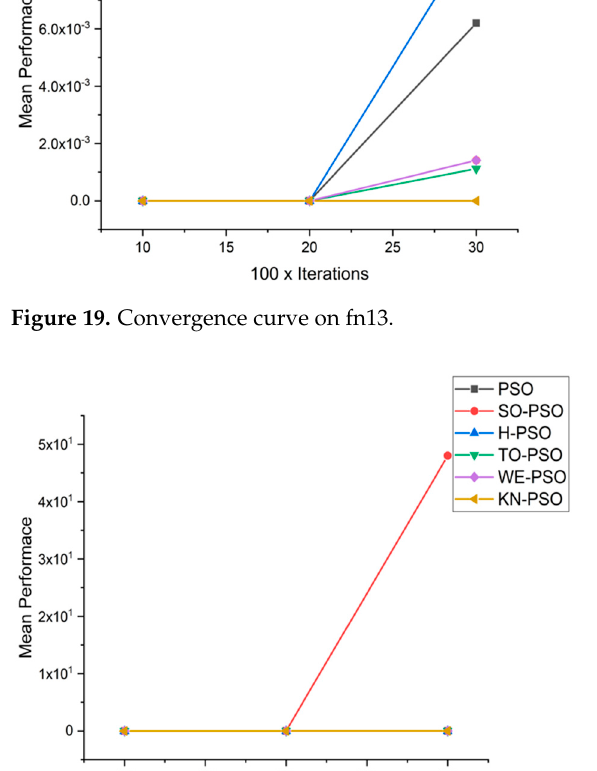
Figure 20. Convergence curve on fn14.